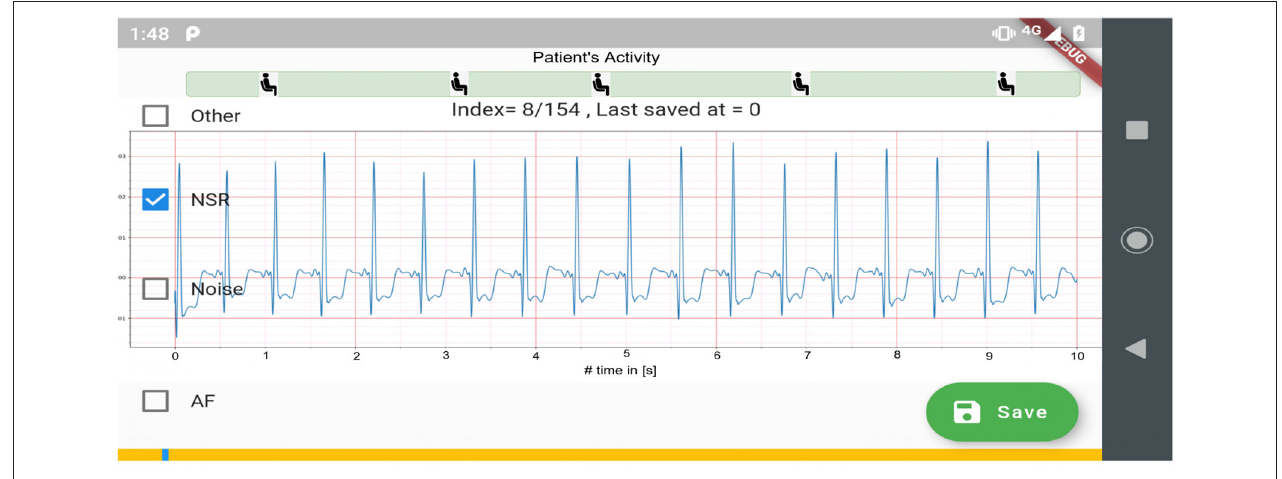
FIGURE 3 | Mobile application used for ECG annotation.